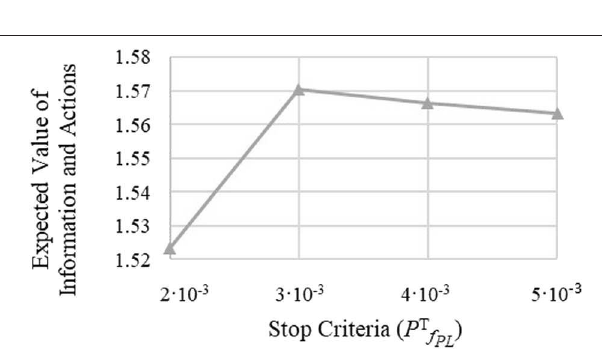
FIGURE 10 | Expected Value of Information and Actions considering the different stop